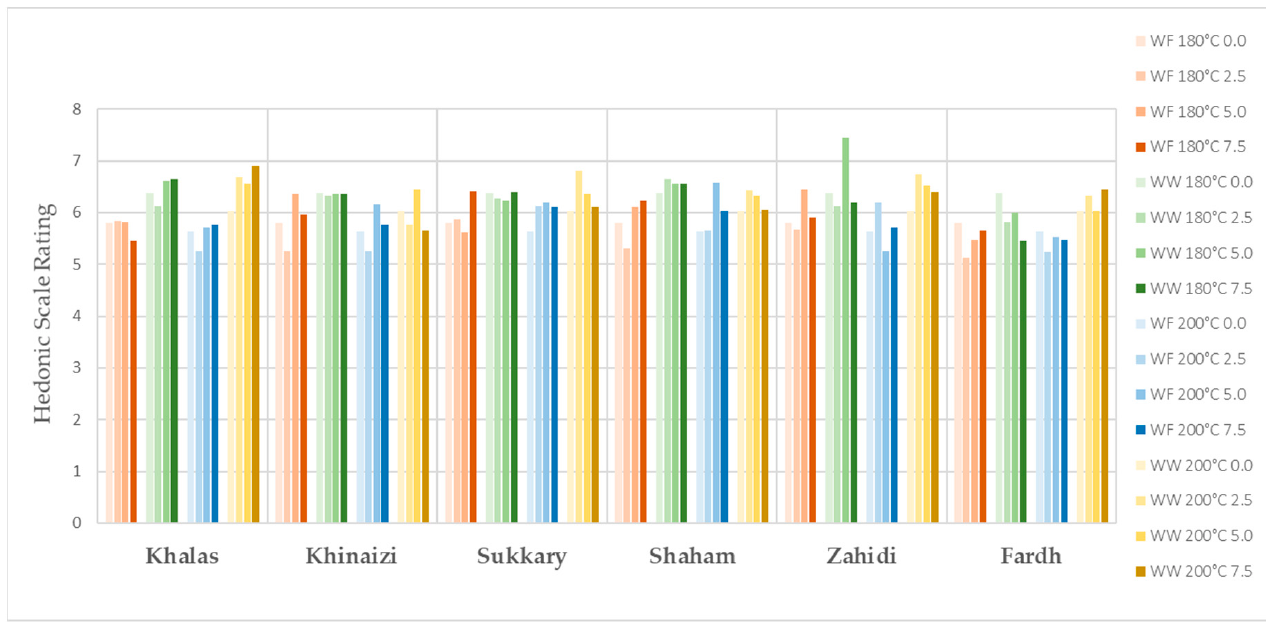
Figure 5. Overall acceptability of date seed composite cookies.